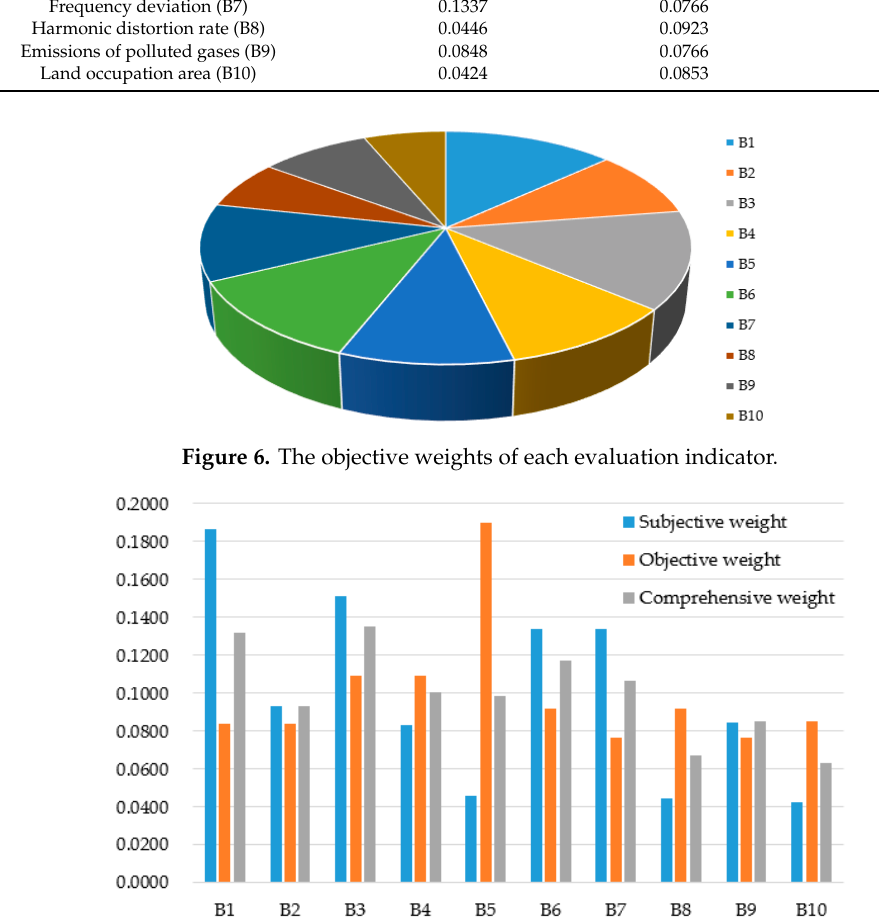
Figure 8. Relevance coefficients of various schemes under various indicators. Table 8. Ranking of schemes. Schemes